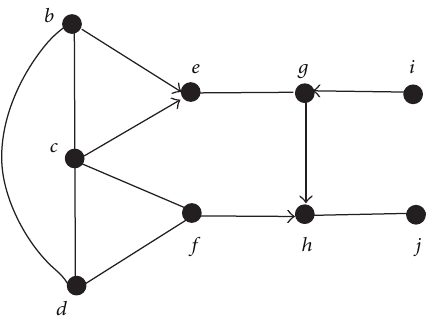
Figure 4: A partially oriented local structure over {𝑏,...,𝑗}